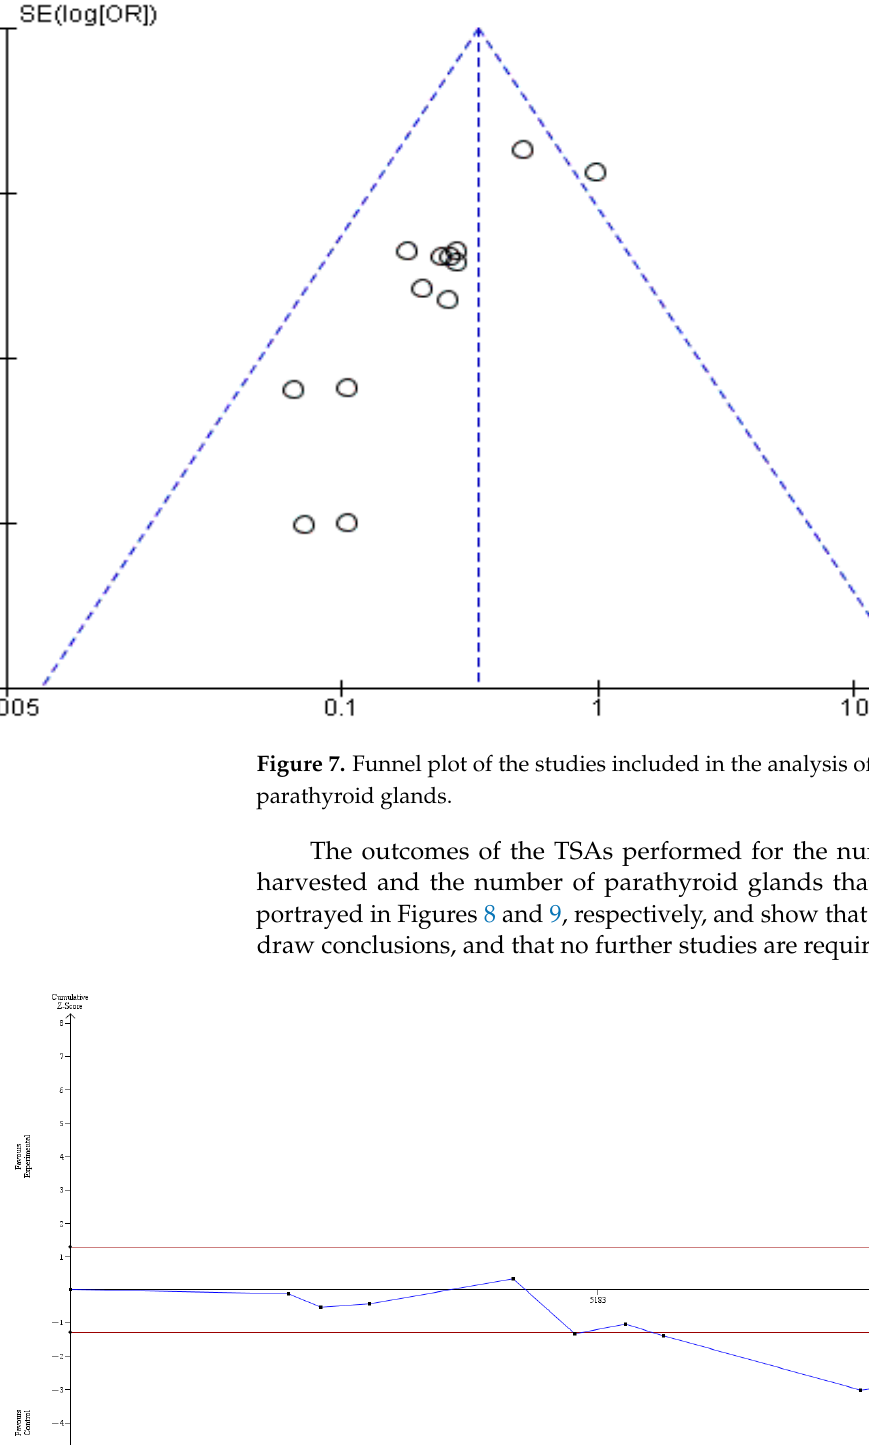
Figure 9. TSA for the number of parathyroid glands removed-z-curve ends outside the not statisti- cally significant zone.